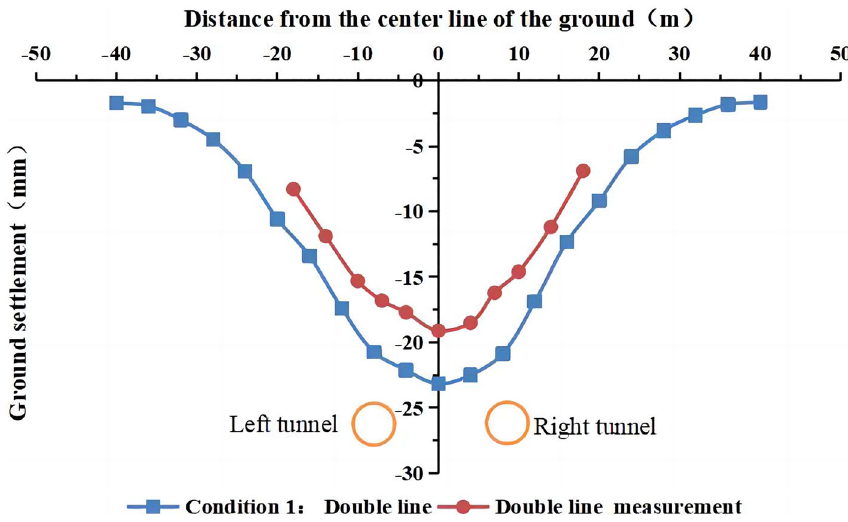
Figure 12. Comparison of the measured and simulated surface settlement after double-line excavation.